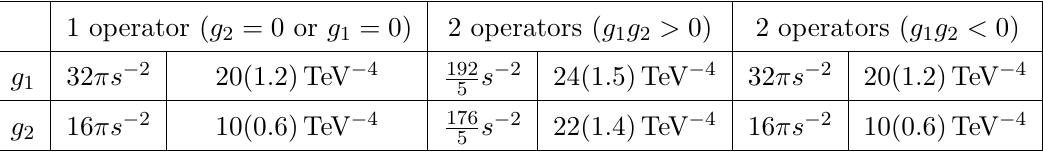
Table 3 . Unitarity constraints on the anomalous couplings when just one coupling is non-zero (second and third columns), and when both couplings are non-vanishing (fourth and fifth columns for the couplings of the same sign, sixth and seventh columns for the couplings of opposite signs). The numerical values of the bounds are given for the collision energy